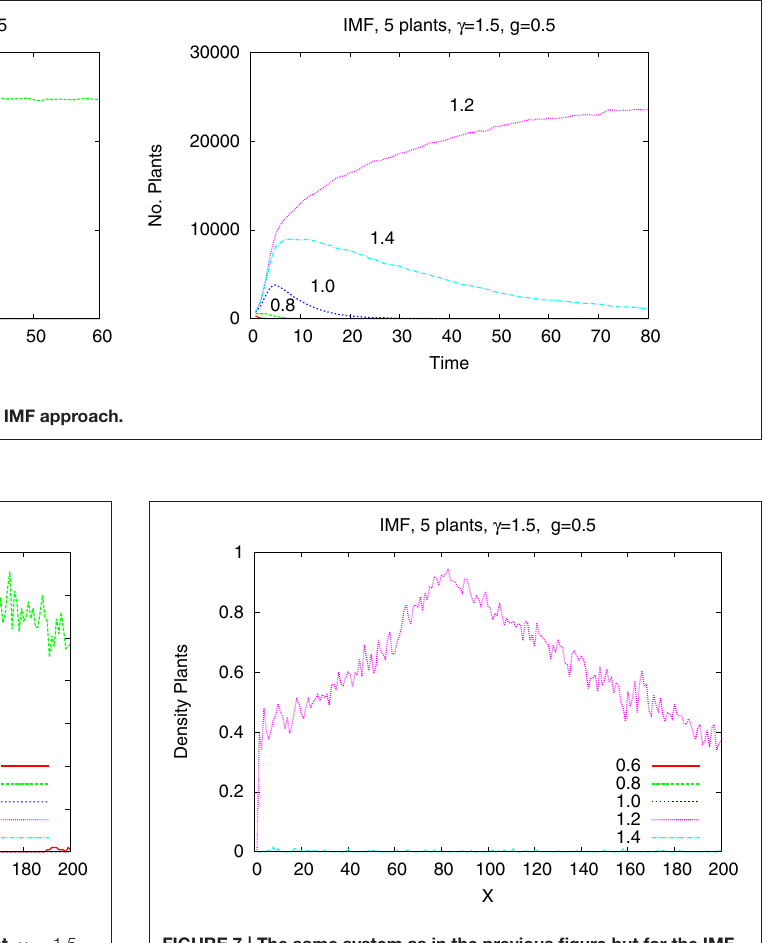
1.5. FIGURE 7 | The same system as in the previous figure but for the =